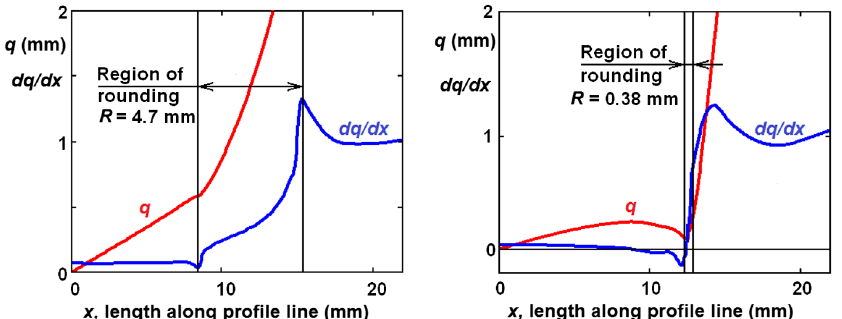
FIG. 8. q ð x Þ and dq=dx for the corner rounding of 4.7 and 1 mm, see geometry in Fig. 1. x ¼ 0 corresponds to the cavity equator.